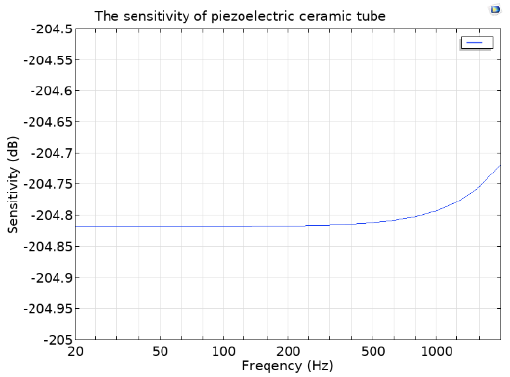
Figure 9. Sensitivity simulation of piezoelectric ceramic tube.